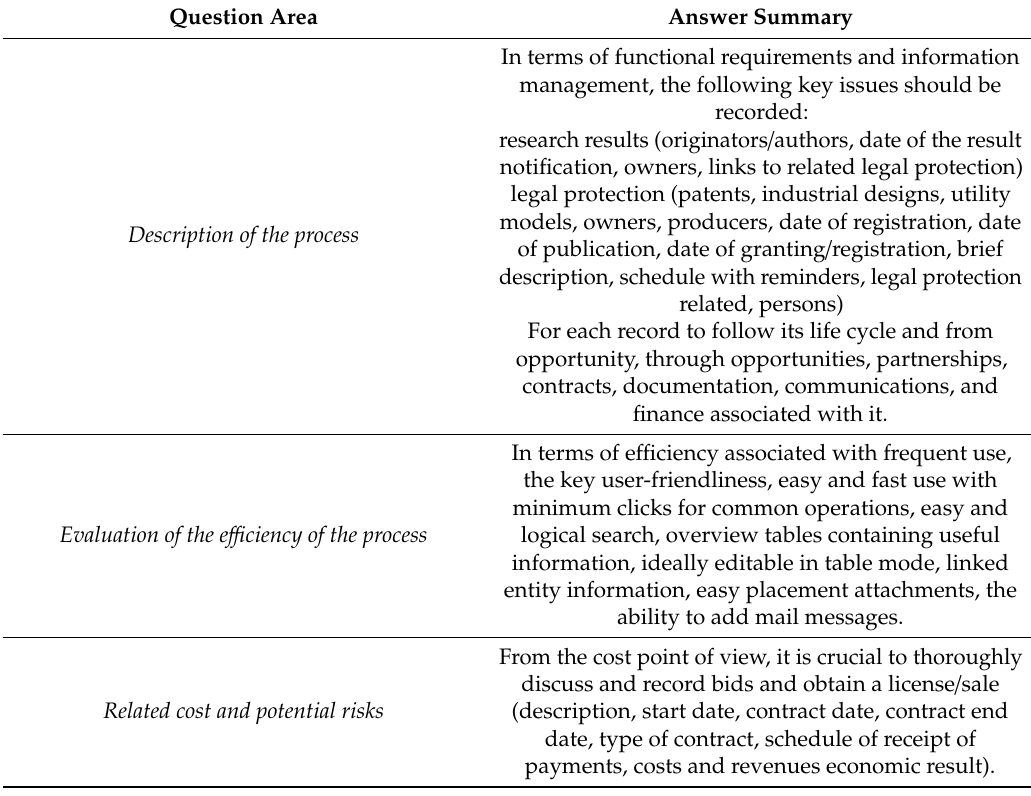
Table 2. Description of main interview